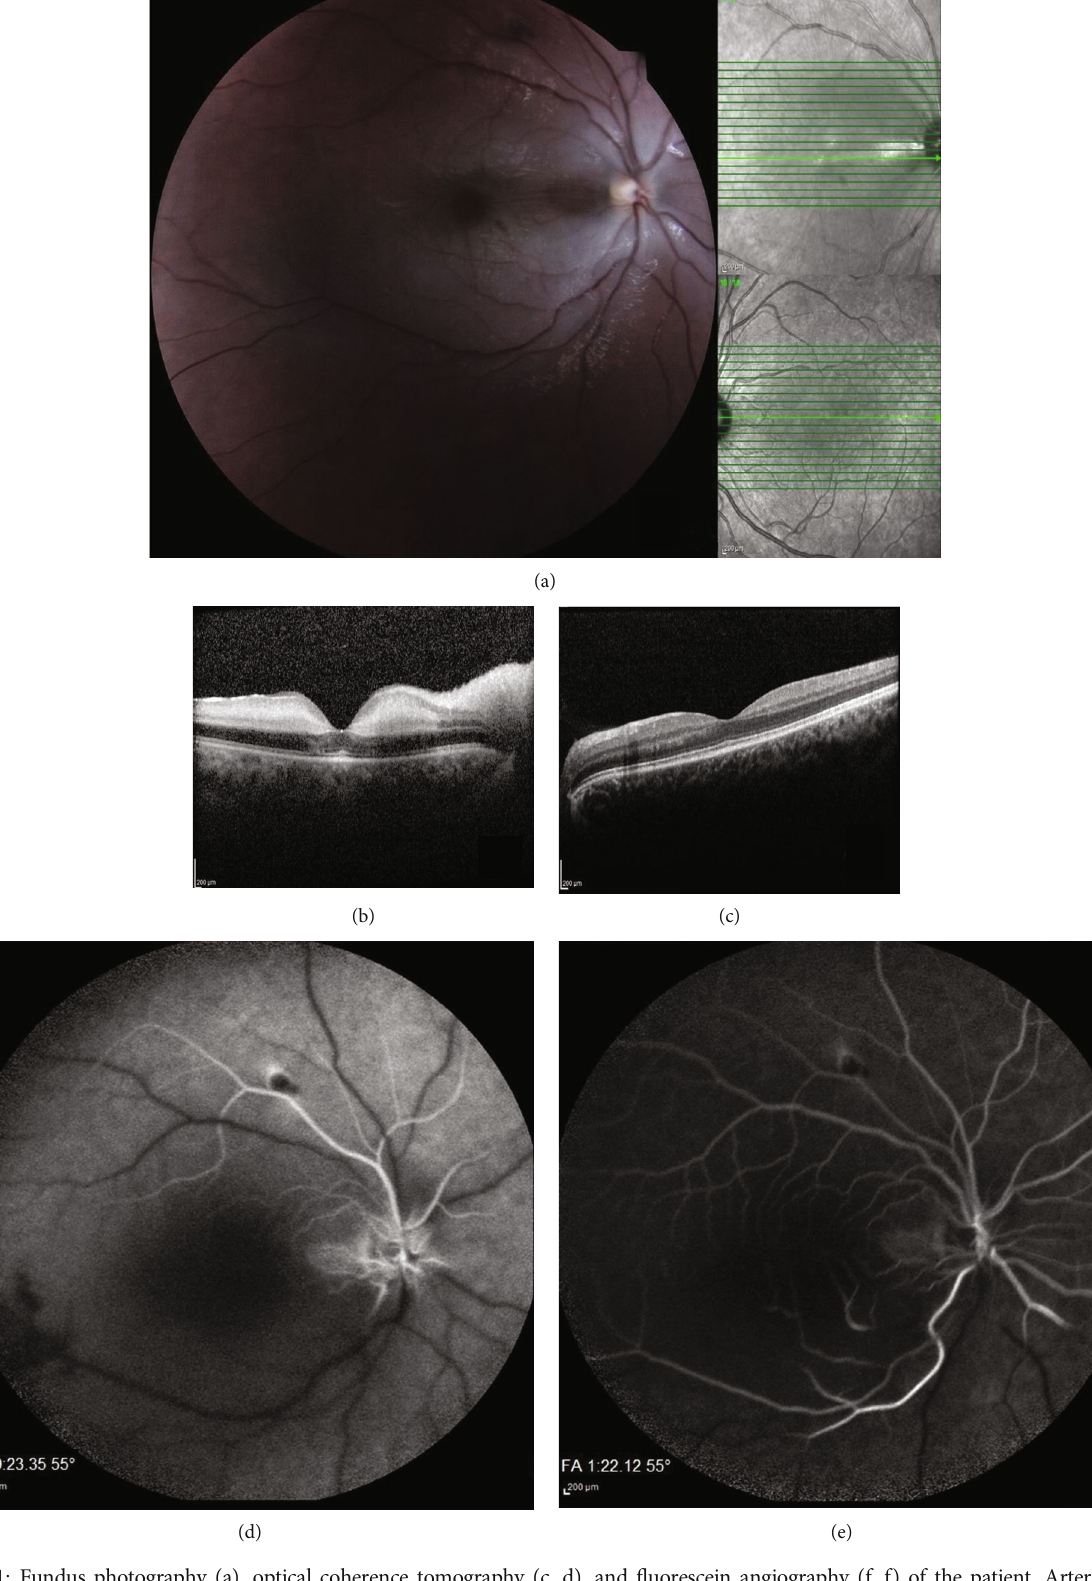
Figure 1: Fundus photography (a), optical coherence tomography (c, d), and fl uorescein angiography (f, f) of the patient. Arterial vessel attenuation, cherry-red spot, and edematous nerve fi ber layer are seen in the fundus photo (a). Thickening and edema of inner retinal layers in the right eye (b) and normal OCT in the left eye (c).Note: no perfused vessels in FAG still after 0 ′ 23 ″ (d) and 1 ′ 23 ″ of dye injection